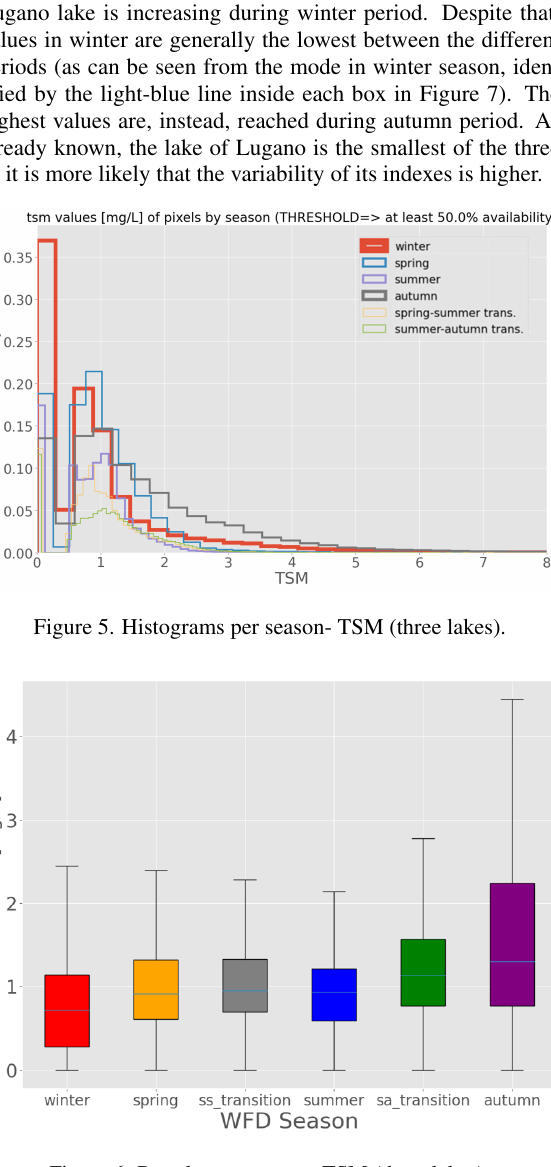
Figure 6. Boxplot per season- TSM (three lakes). CHLOROPHYLL -